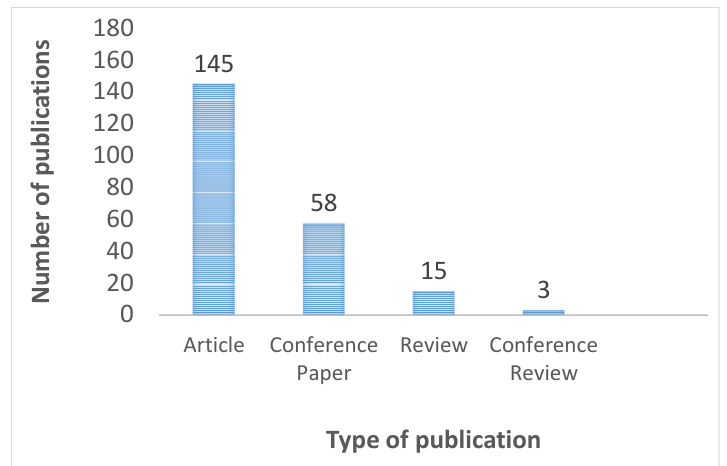
Figure 2. Number of documents published per year.